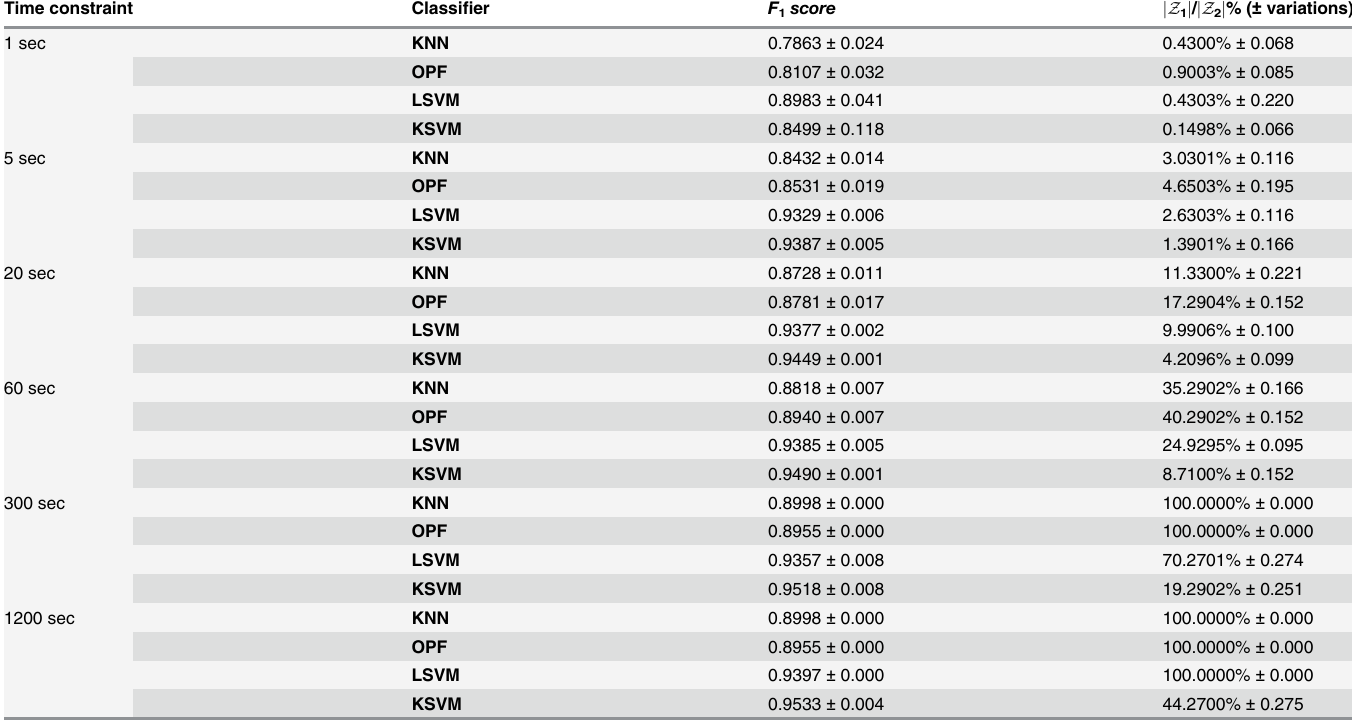
Table 7. Cod-RNA dataset: Predictivity performance over Z 3 and final training set size, j Z 1 j as a percentual of j Z 2 j , for each classification model and learning time constraint using random selection.